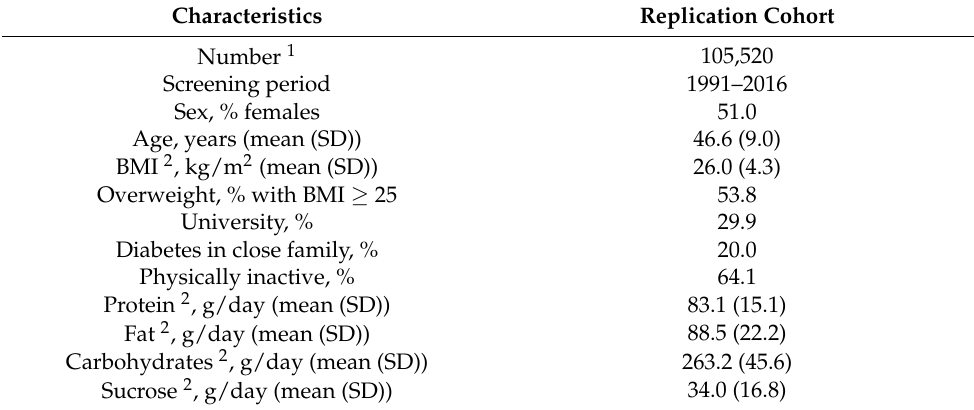
Table 2. Characteristics of the participants in the replication cohort.